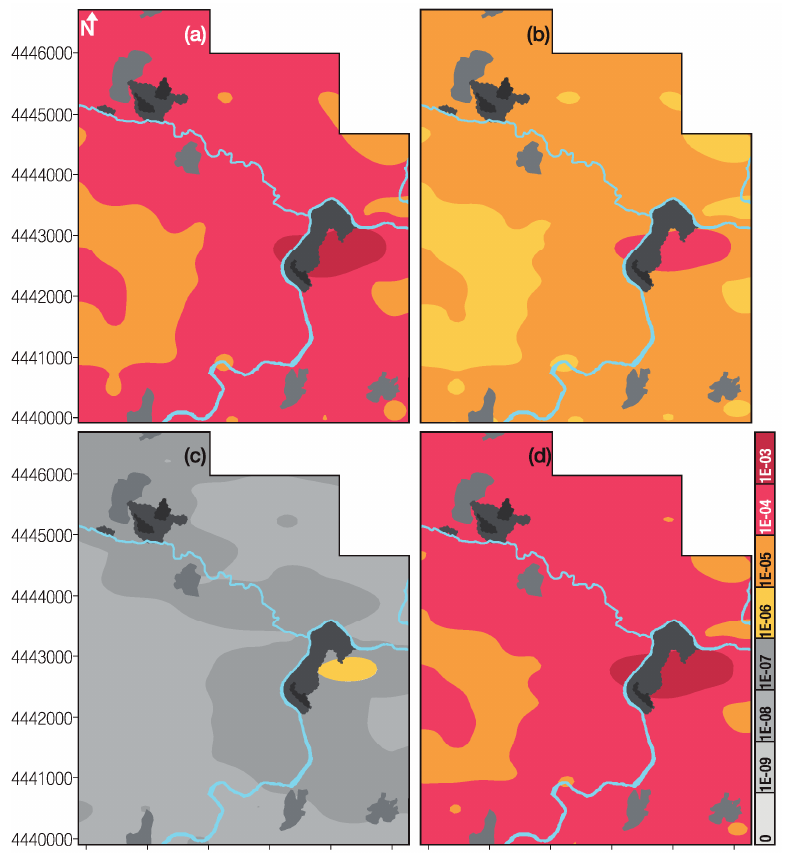
Figure 9. Spatial distribution of the Carcinogenic risk adjusted for both children and adult considering ( a ) ingestion; ( b ) dermal contact; ( c ) inhalation routes; and ( d ) the cumulative